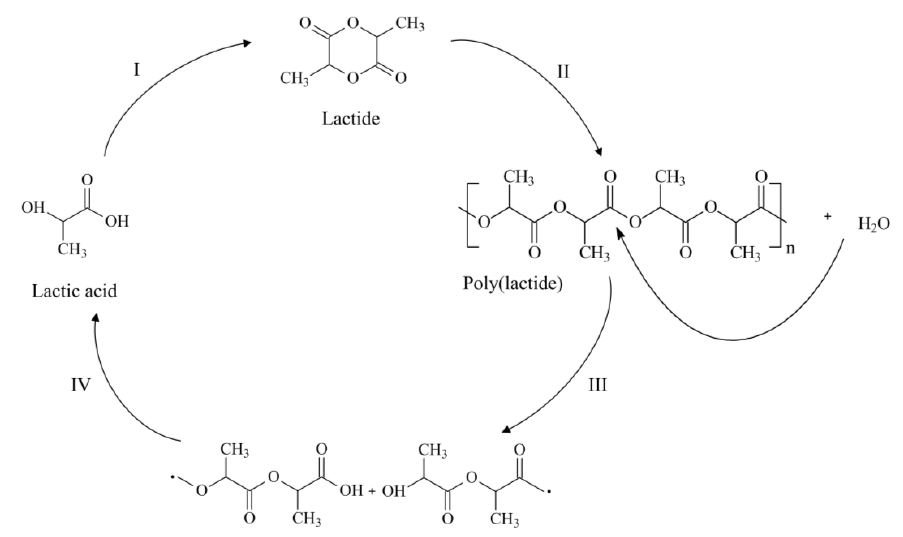
Figure 1. Schematic illustration of poly(lactide) PLA cycle. Production of the monomer (I), polymerization (II), degradation into shorter polymer chains (III), and, finally, into lactic acid (IV)